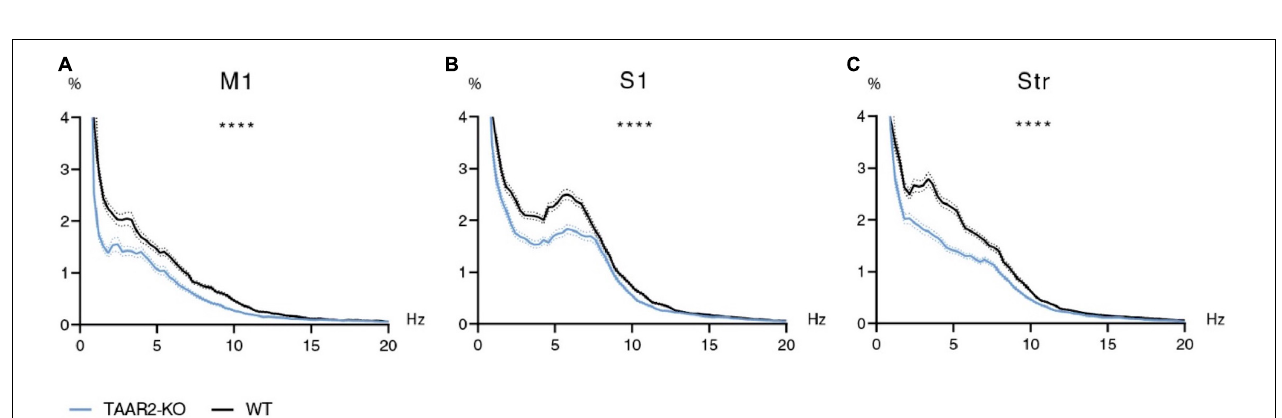
FIGURE 5 | | Electrophysiological power spectra in the brain regions of TAAR2-KO vs. WT mice. (A) Power spectral density of primary motor cortex (M1) electrocorticogram (ECG). (B) Power spectral density of somatosensory cortex (S1) electrocorticogram. (C) Power spectral density of local field potentials in the striatum (Str). X-axis—signal frequency in Hz; Y-axis—power spectral density in % of total density. Blue and black lines—power spectra of TAAR2-KO and WT mice, respectively; dotted lines—standard error of the mean (SEM). **** p < 0.0001 two-way ANOVA with Sidak post hoc test.